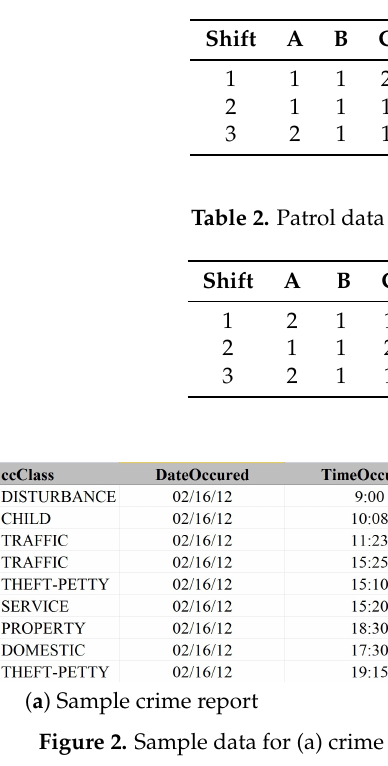
Table 1. Crime data for 3 shifts.